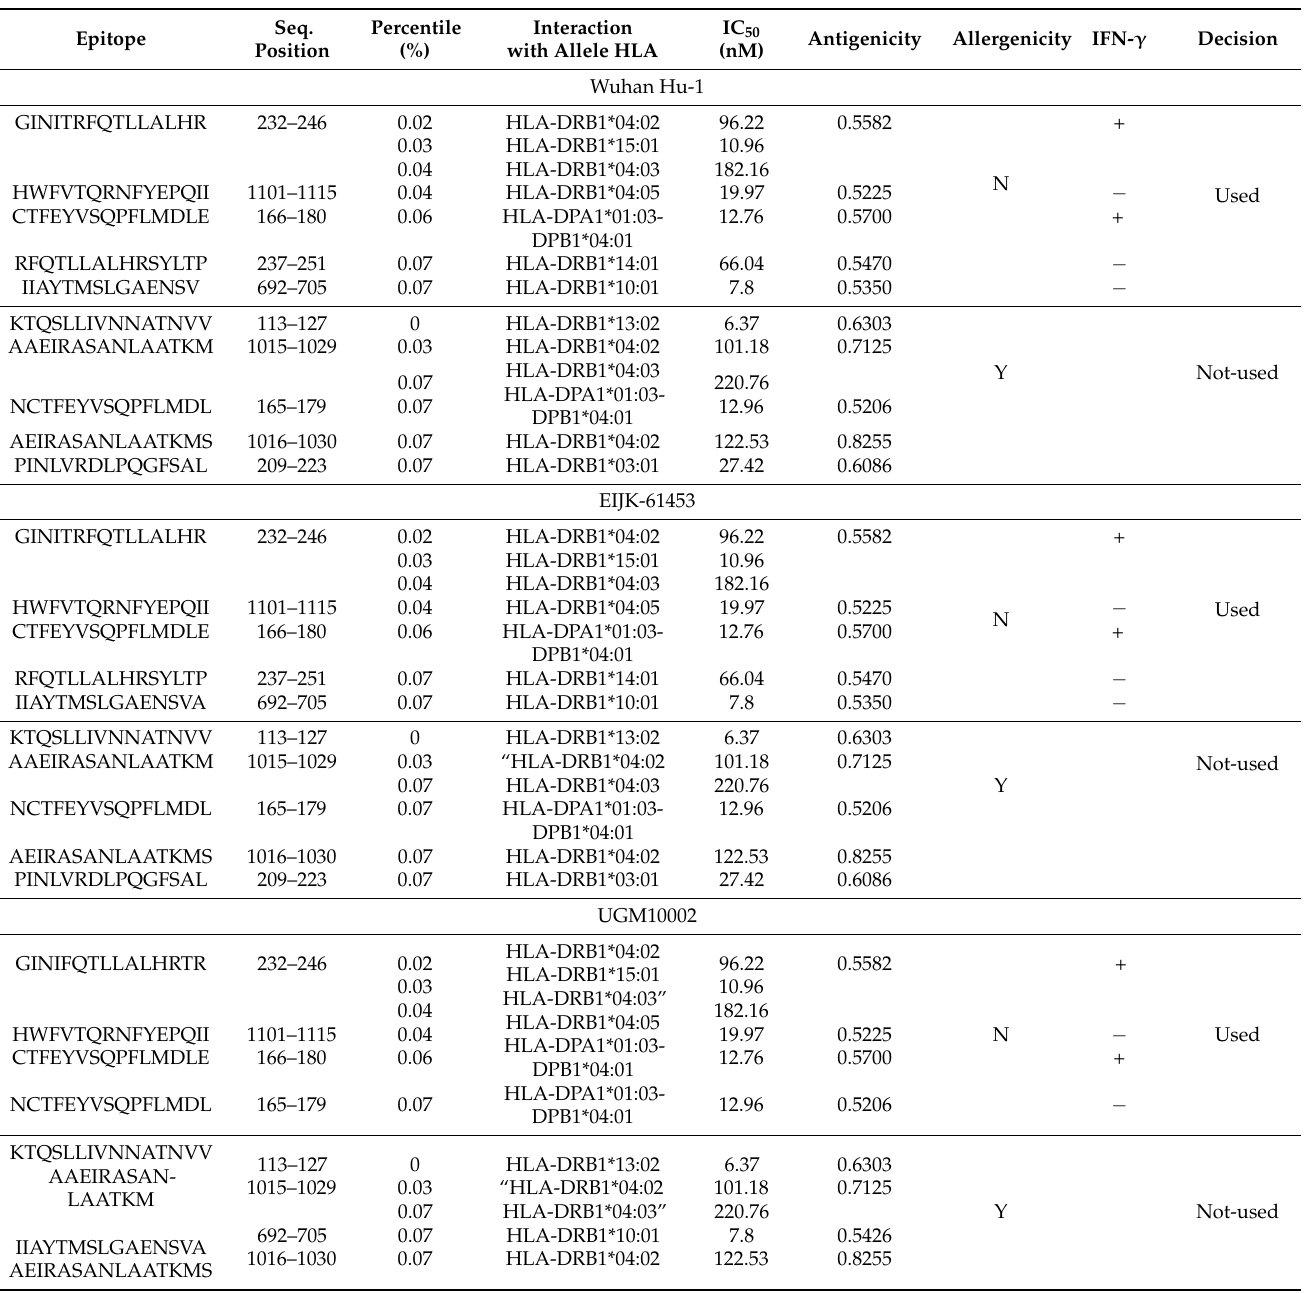
Table 4. Selected epitopes from the HTL